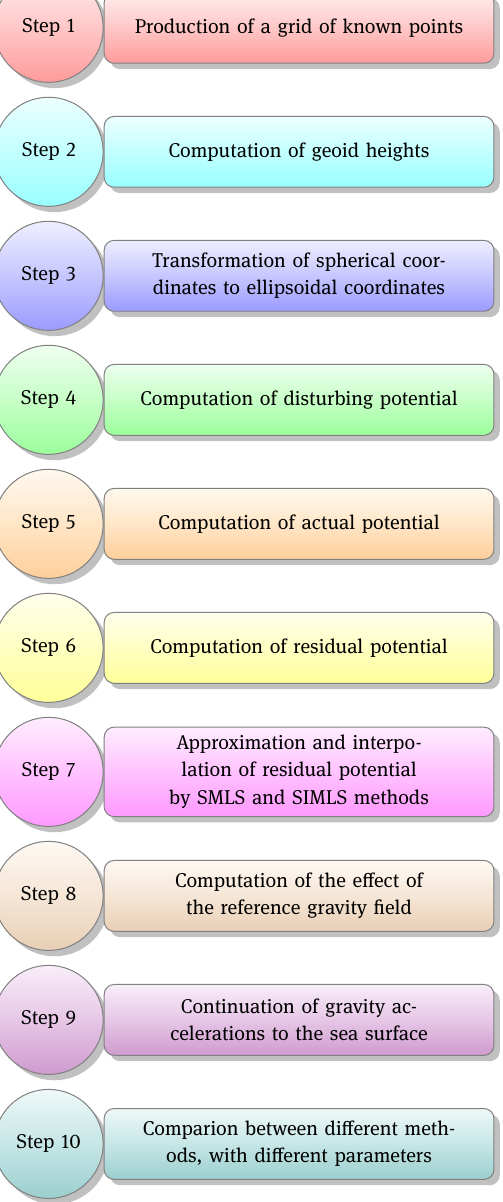
2 − Computing geoid height from Mean Sea Level (MSL) data and Sea Surface Topography (SST, which is also known as Dynamic Topography(DT)) data. To this end, we use the MSL data from CSRMSS95 MSL model ((Kim, et al, 1995)), and SST data from the POCM4B model((Forste, et al, 1998)), which is based on the spherical harmonic ex- pansion of the DT (up to degree and order 360), using the specified coefficients. geoid height ( N ) is determined